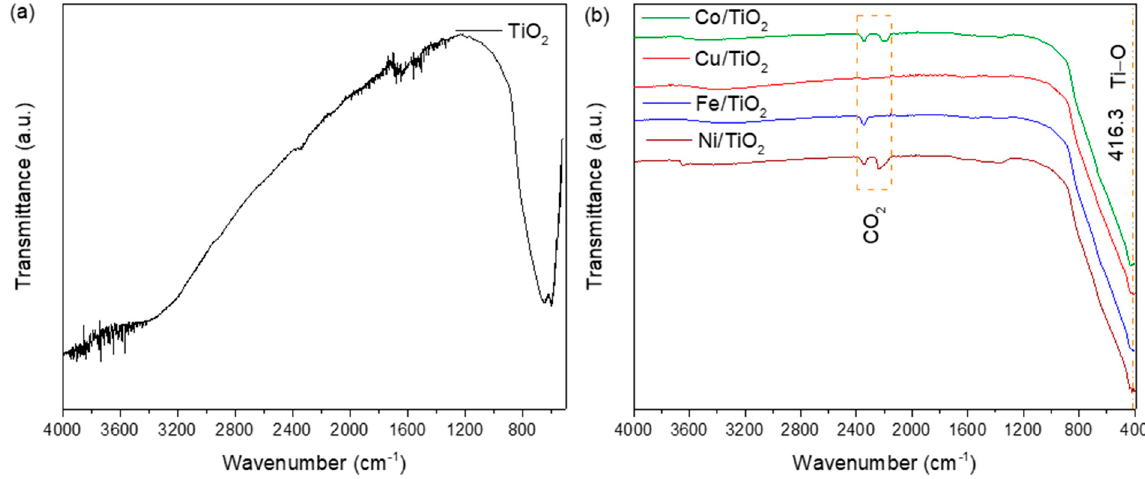
Figure 6. FT-IR spectra of photocatalysts. ( a ) FT-IR peaks of pure TiO 2 nanoparticles. ( b ) FT-IR